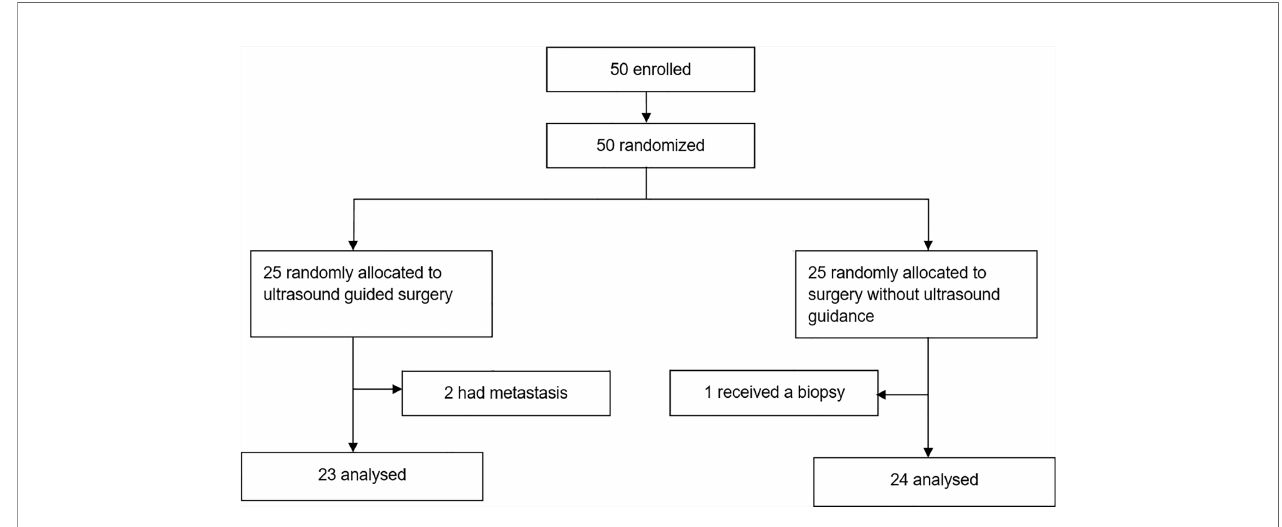
FIGURE 1 | Flowchart.